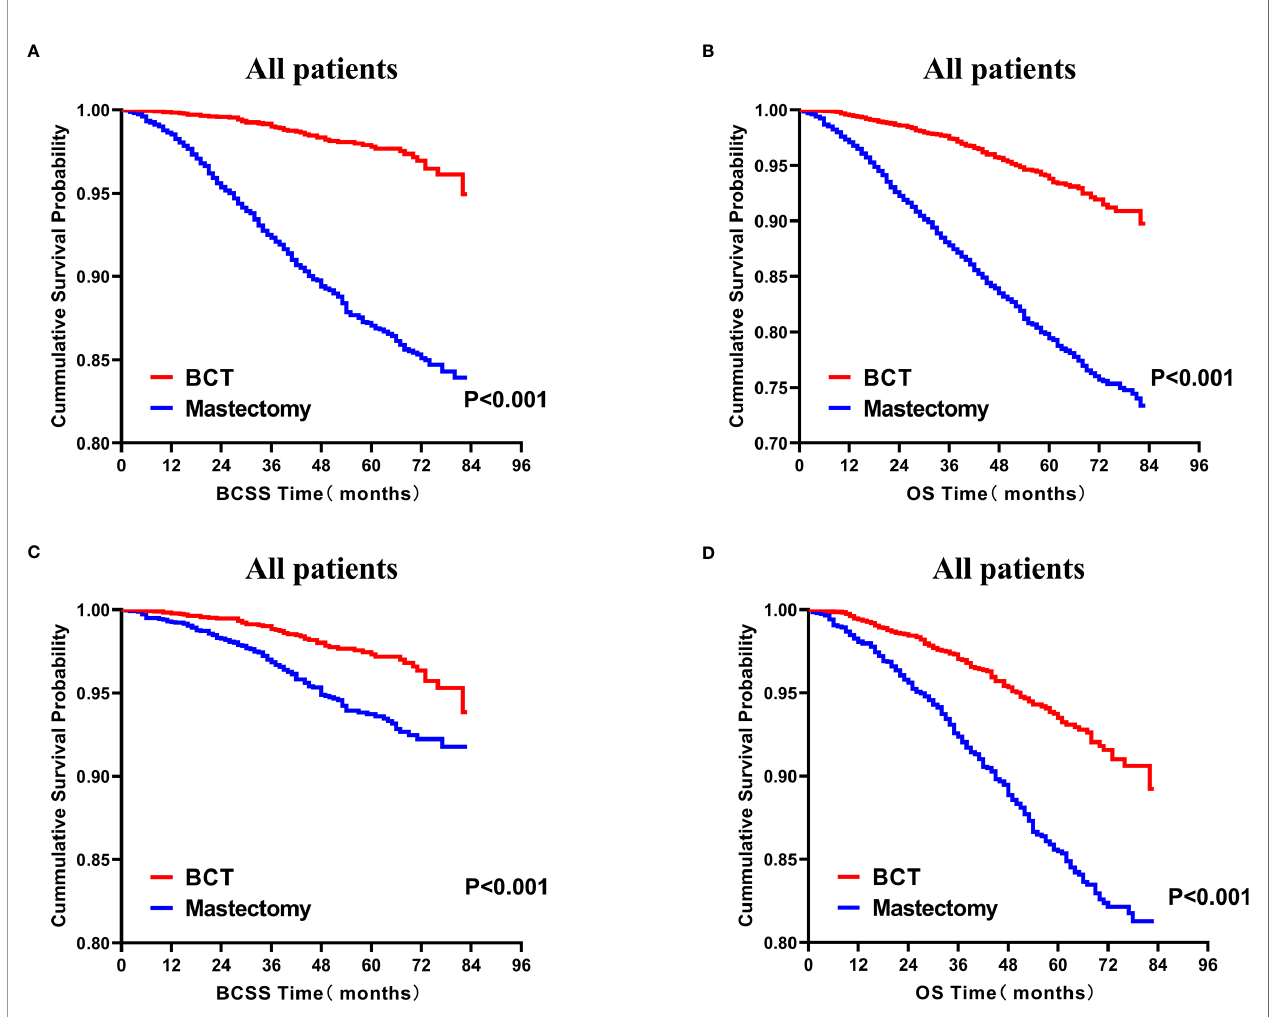
FIGURE 2 | Kaplan – Meier curves for BCSS (A) and OS (B) by treatment type for all patients before PSM and BCSS (C) and OS (D) by treatment type for all patients after PSM; BCT versus mastectomy. BCSS, breast cancer speci fi c survival; OS, overall survival; PSM, propensity score matching; BCT, breast-conserving